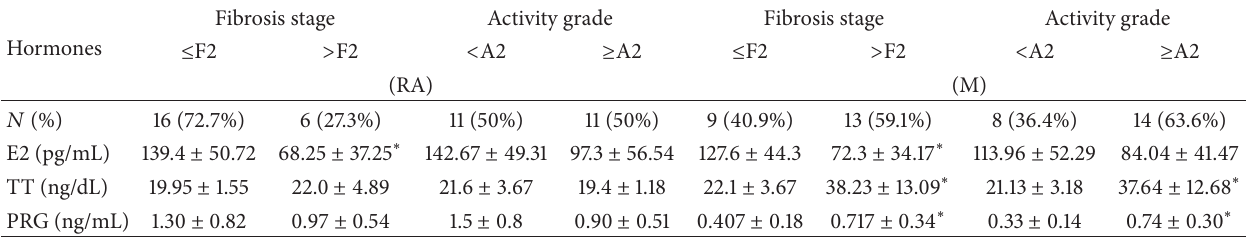
Table 2: The relation between fibrosis and hormonal levels in reproductive aged and menopausal